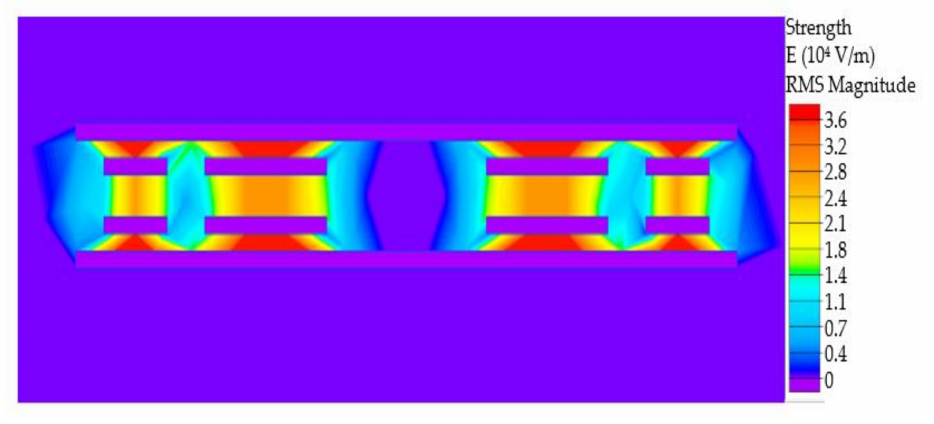
Figure 9. EF emission of S-CPT.